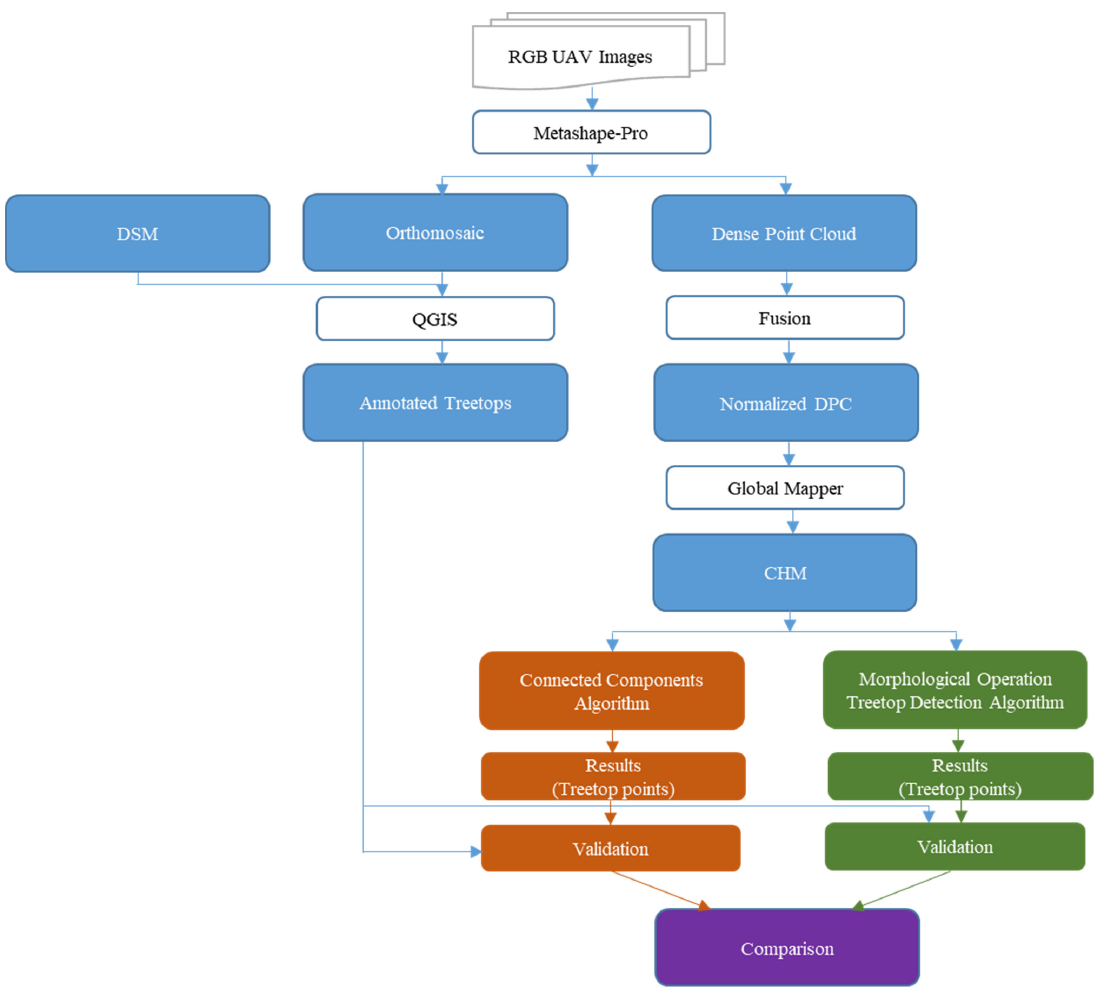
Figure 3. Study workflow: processed data (blue), treetop detection algorithms’ process (orange and green), algorithm results comparison (purple), and commercial software used (white box).